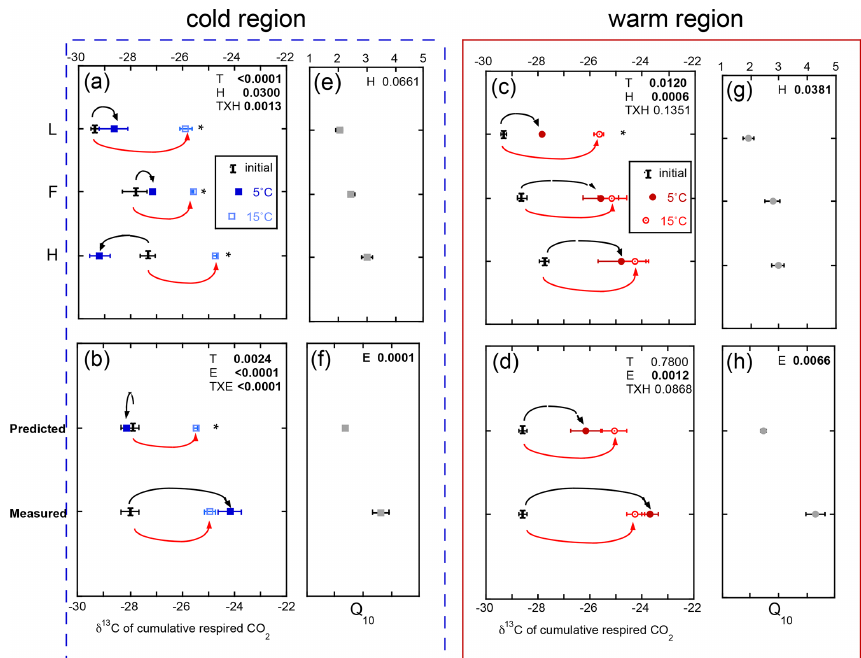
Figure 4. The δ 13 C of the total cumulative respired CO 2 comparing individual horizons incubated in isolation (isolated experiment; L , F , and H ; a, c ), calculated as a whole profile from those isolated horizons (predicted), and measured directly as a whole-profile (measured; b, d ). The corresponding temperature sensitivity ( Q 10 ; e, f, g, h ) of the total cumulative respiration for the same incubation period. Values are provided separately for the soils from the cold (blue, left) and warm regions (red, right). Values are given as the mean of the three sites ± standard error with the initial bulk soil δ 13 C included for reference ( I ). The effects of temperature ( T ), horizon ( H ), or experiment ( E ) and their interaction term ( T × H or T × E ) are given for all three effects, with significance ( α = 0 . 05) denoted in bold. Any significant effect of temperature within horizon (a, c) or within experiment (b, d) is denoted with an